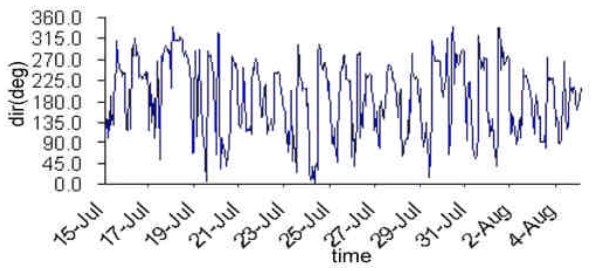
Figure2. Hourly time series of wind direction (UD) against time (24h interval) Fig. 2. Hourly time series of wind direction ( UD ) against time (24- h interval).